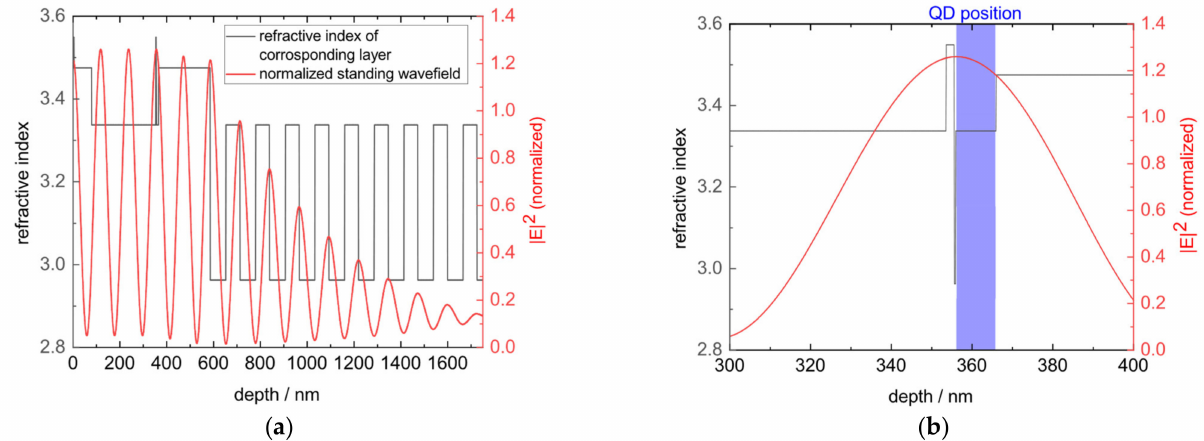
Figure A6. Simulated standing wave field of the photonic sample at the design wavelength and temperature (795 nm, 4 K) as an overview ( a ) and a more detailed view at the QD region in ( b ).